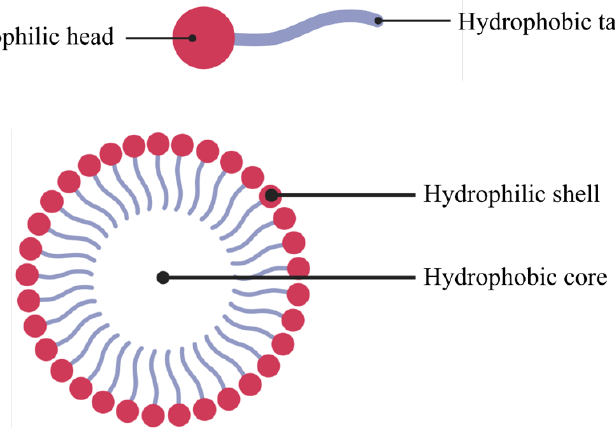
Figure 7. Labelled structure of a micelle.